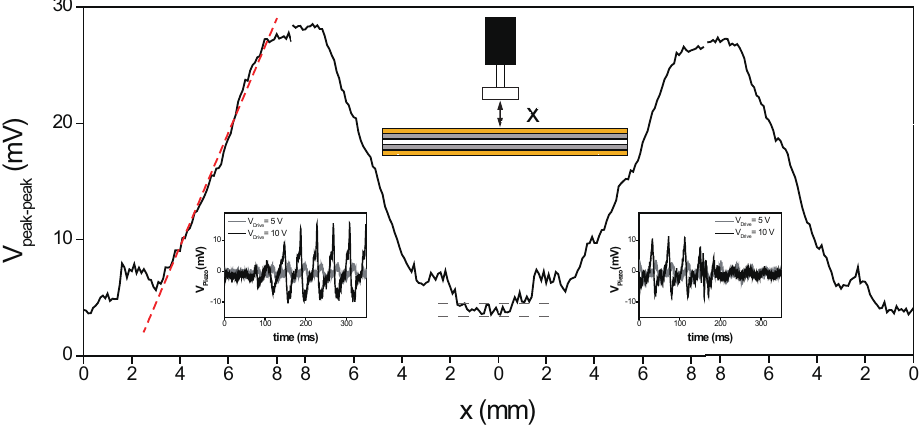
Figure 4. Tactile sensing response as a function of the contact separation. The piezoelectric peak − to − peak voltage V peak − peak is monitored while the contact distance x between the sensing element and the glass plate is varied. Between the loading ( x = 0 mm) and unloading ( x = 8 mm) of the physical contact, a linear increase and decrease in the sensing signal can be observed. When repeated, the sensing element shows a steady response. The red dotted line is a linear fit with a slope of 4.9 mV/mm. In addition, a pair of gray dotted lines in the middle indicates the measurement uncertainty ( ∼ 1 mV) in this experiment, which results in the minimum detectable contact separation around 200 µ m. The insets show the time-transient curves when the contact is removed (inset on left) and when the contact is made (inset on right) under two different drive voltages of 5 and 10